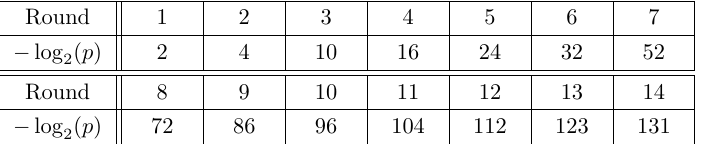
Table 6: Upper bound on the differential probability p of SKINNY-128